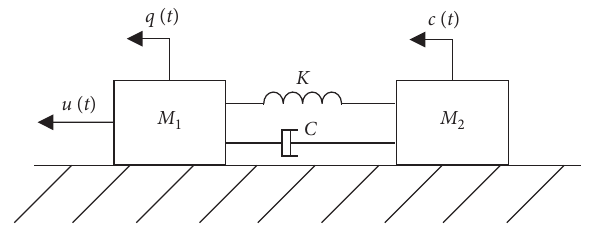
Figure 1: The schematic diagram of the two-mass-spring